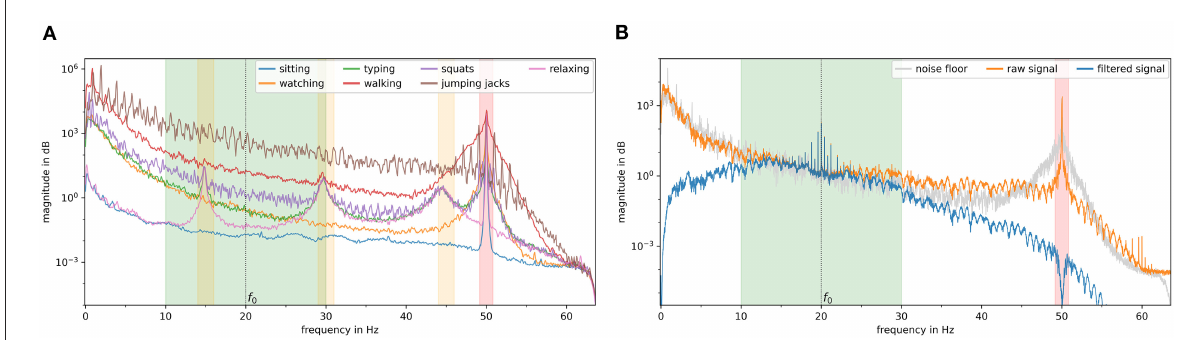
FIGURE8 Analysis of the frequency spectra (PSD) of the noise floor (A) : interference generated by seven activities; 50Hz power line noise (red band); unknown interference source, oscillation at 15Hz with its first and second harmonics (orange bands). Analysis of the frequency spectra (PSD) of the desired signal extracted from the raw measurements (B) : noise floor, overall average of the activities (gray); raw signal (orange); filtered signal (blue); selected bandwidth B of 20Hz, pass-band from 10 to 30Hz (green band).